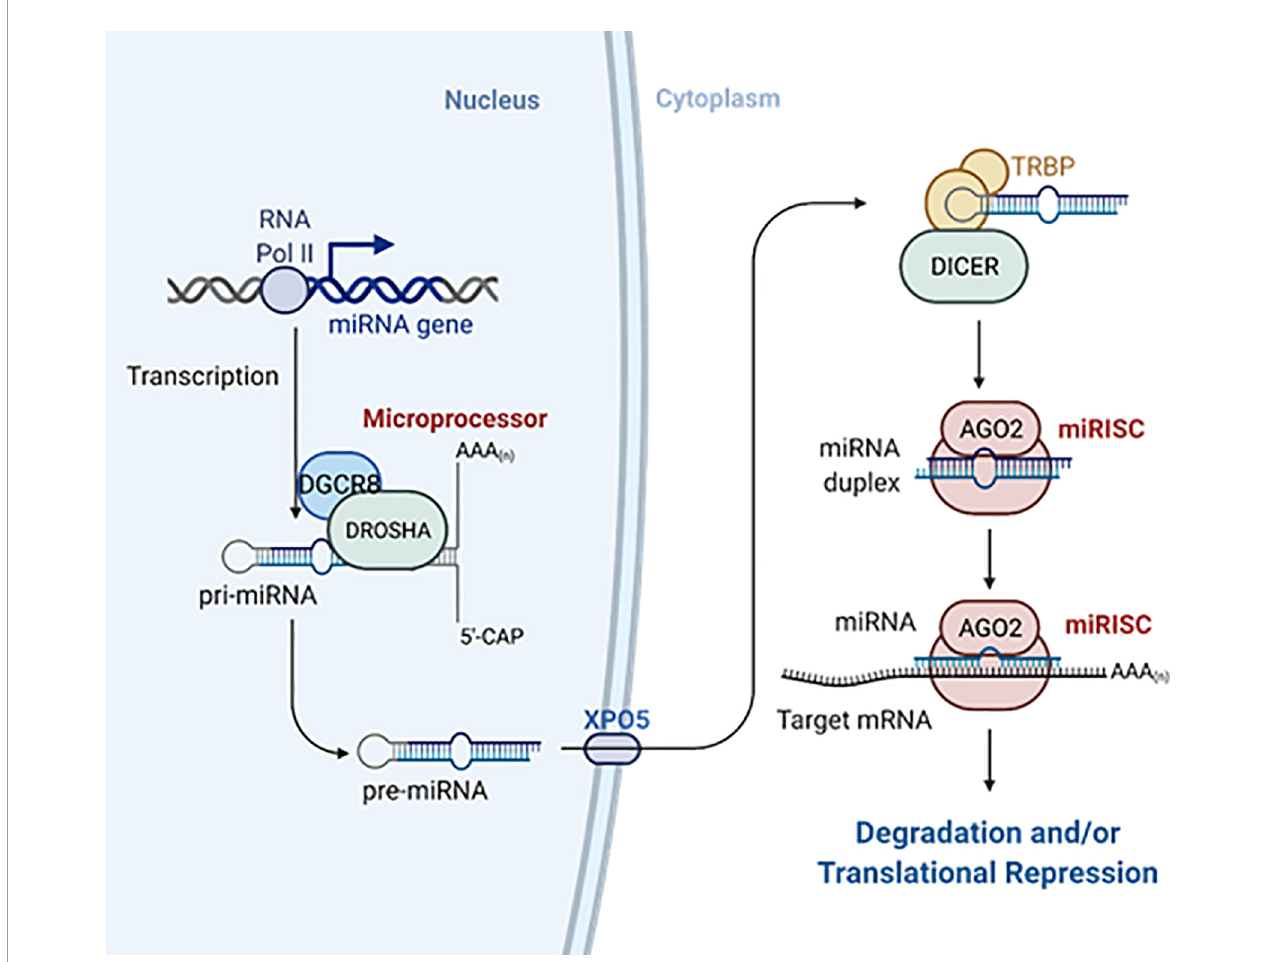
FIGURE 2 | MiRNAs biogenesis. MiRNAs are transcribed as longer primary transcripts (pri-miRNAs) that are fi rst processed in the nucleus by the Microprocessor complex to generate ~70-nucleotides pre-miRNAs that are exported to the cytosol by exportin-5 (XPO5). Pre-miRNAs are further processed by Dicer and TRBP into small RNA duplex. The mature miRNA is loaded with Argonaute proteins into the miRISC. Created with Biorender.com. See the main text for further